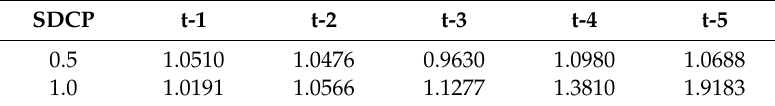
Table 4. The E / O (expected number / observed number) of the MCCRM.